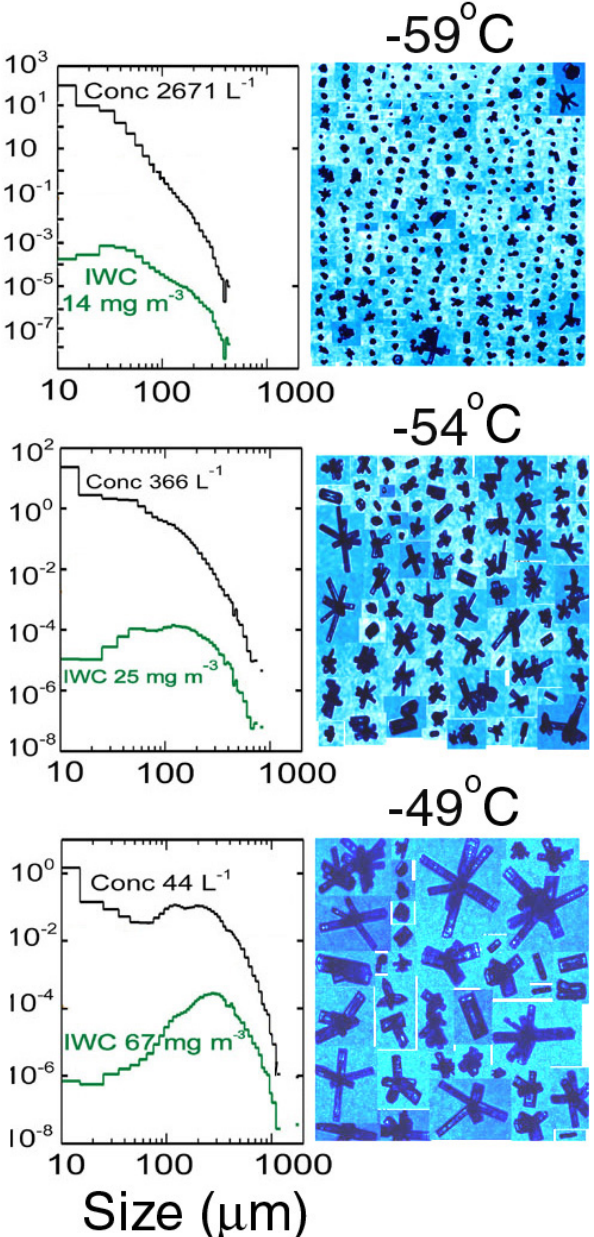
Fig. 2. Example from the SPARTICUS project showing (left) con- Figure 2. Example from the SPARTICUS project showing (left) concentration and mass centration and mass particle size distributions derived from the 2D- particle size distributions derived from the 2D-S and (right) images from the CPI. S and (right) images from the